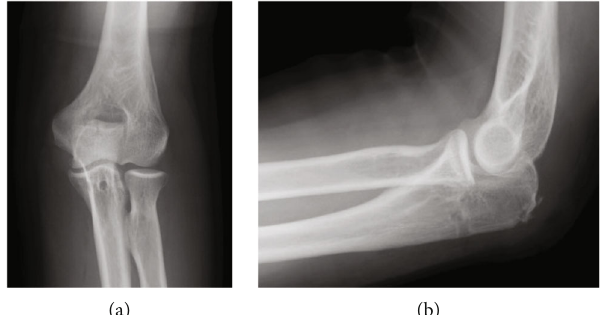
Figure 3: Plain radiography images of the left elbow after the osteosynthesis. Postoperative plain radiography images demonstrated that the avulsion fracture fragments were reduced (a,